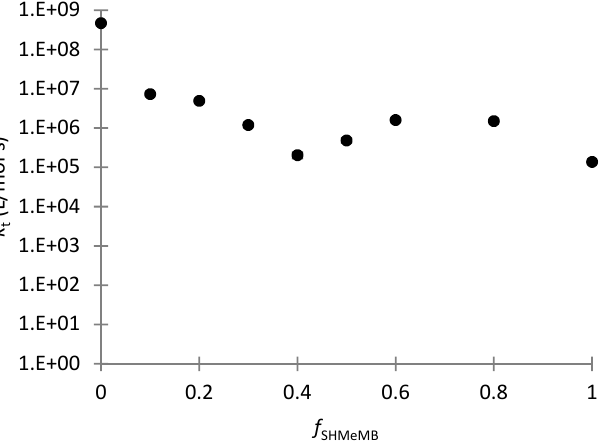
Figure 11. k t of SHMeMB:AM copolymers estimated for copolymerizations done at 50 °C with 0.5 wt % V-50 and 15 wt % monomer.